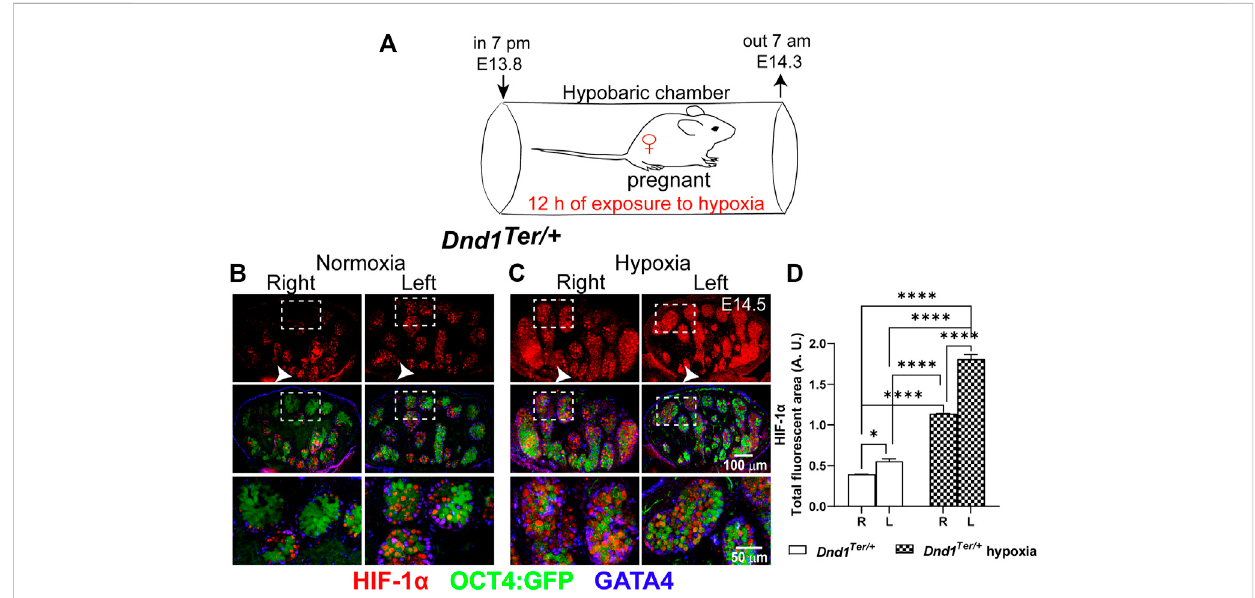
FIGURE 1 Low systemic oxygen induces HIF-1 α in male gonads. (A) Experimental design to induce hypoxia in vivo. Pregnant 129 Sv/J Dnd1 Ter/+ :Oct4:GFP femaleswereexposedto12 hofhypoxia(10%oxygen)betweenE13.8andE14.3.Subsequently,malegonadsweredissectedatE14.5.EvaluationofHIF-1 α byimmuno fl uorescence in (B) normoxia(n=5embryos),theleftgonadshavemoreHIF-1 α positive (red)Oct4:GFPpositive (green)germcellscompared to the right gonad, in which HIF-1 α positive cells were often localized near the rete testis (arrow head) and (C) After exposure to hypoxia (n